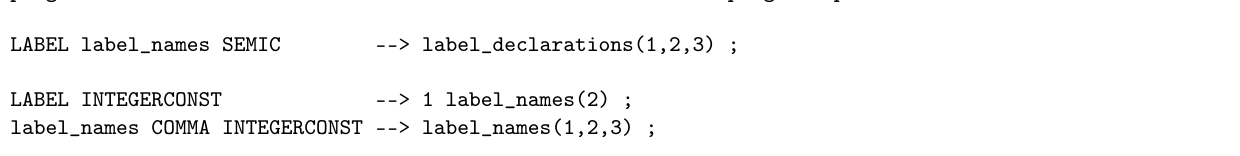
Figure 4. Parsing Pascal: a subset of rules of the LLR-system not resembling a grammar. Tables 4 and 5 contain running times of parsing all four programs with all three algorithms. The running times are again compared to the bison -generated parser: the parsers based on the LLR-system that was made specifically for LLR-parsing are less than 60% slower if the CPU time of the parsing is compared and less than 20% percent if both scanning and parsing are considered. Table 4. Parsing of TANGLE , WEAVE , TEX and METAFONT using two different LLR-systems; running times of parsing in seconds and comparison to the bison -generated parser. Full Backjumping Limited Backjumping dfa-Based Factor Time in Secs. Factor Time in Secs. Factor Time in Secs.